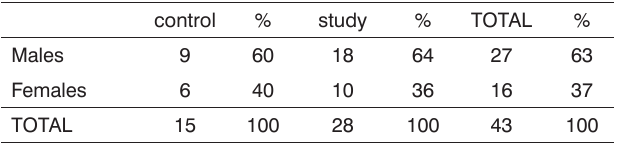
Table 1. Gender distribution of the control and study groups.